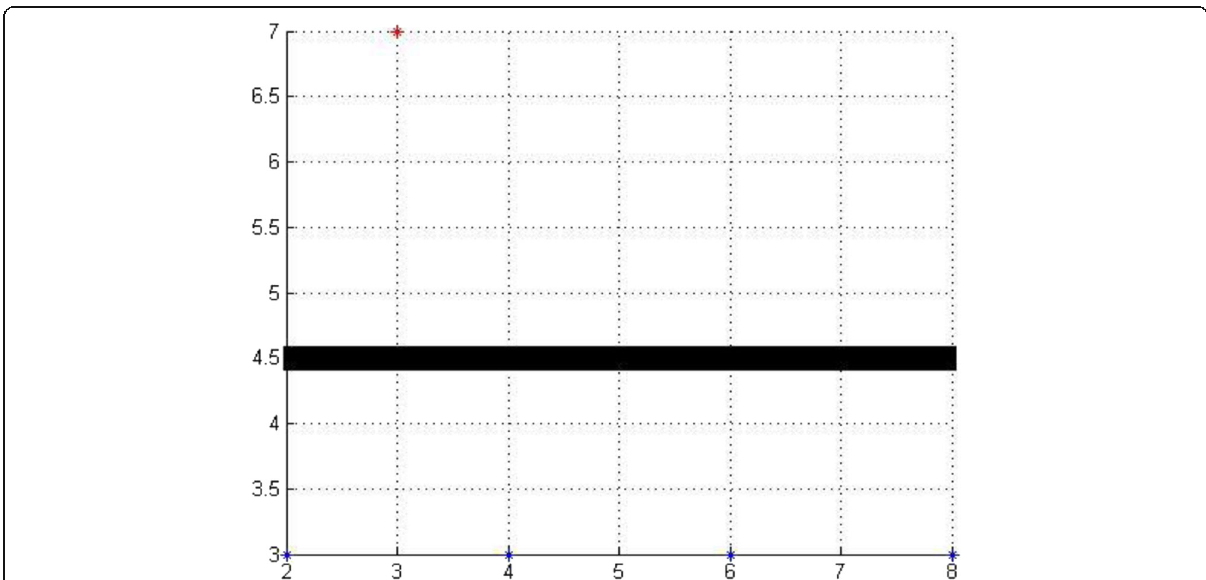
Fig. 12 Measurement results of the 20 cm thick concrete wall (red star is the source location; blue stars are the four receiving antennas; wide black line is the shelter wall)